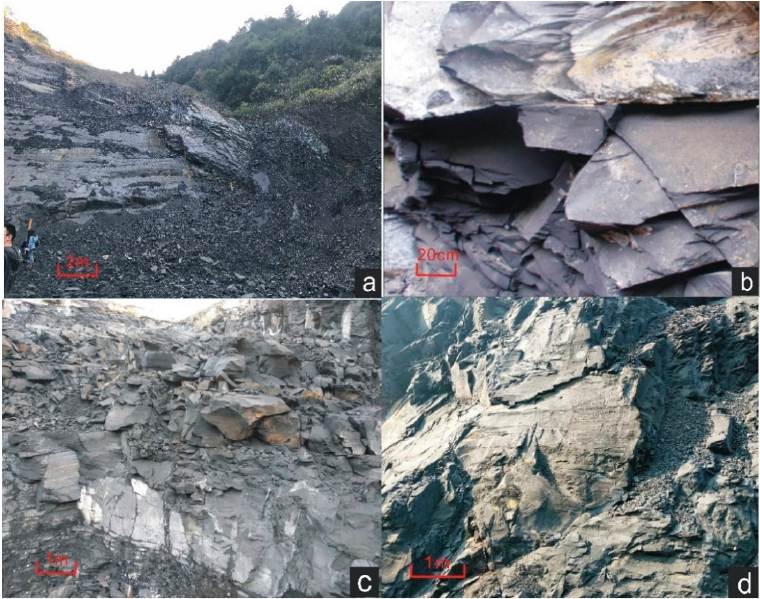
Figure 3. Niutitang Formation shale in northwestern Hunan: ( a ) outcrop at Huayuan (109.467028,